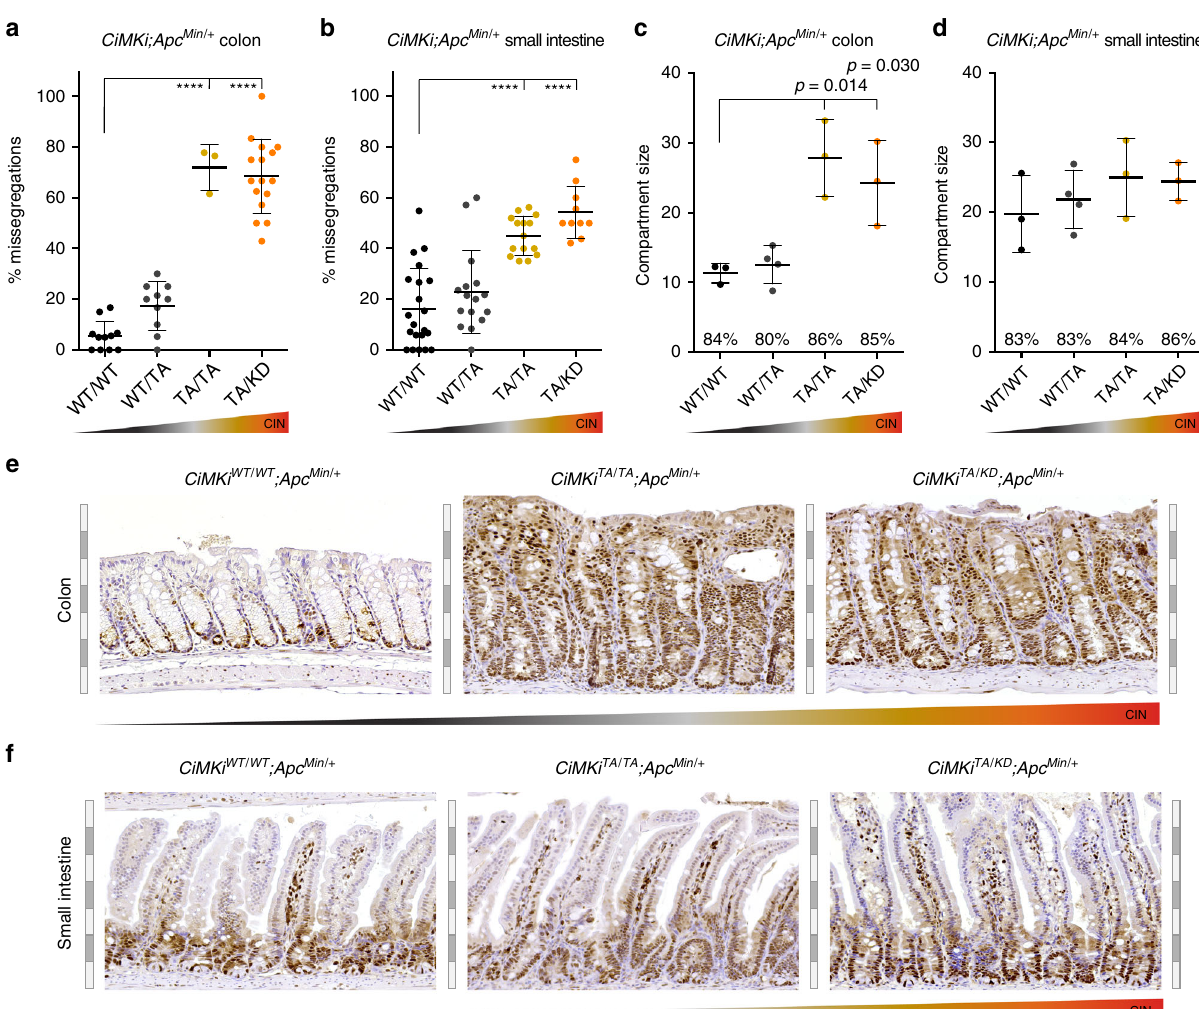
Fig. 4 Enhanced proliferation in colon but not in small intestine. a , b Quanti fi cation of chromosome segregation fi delity by time lapse imaging of colon organoids ( n = 11 (WT/WT), n = 10 (WT/TA), n = 3 (TA/TA), n = 16 (TA/KD)) ( a ) and small intestine organoids ( n = 21 (WT/WT), n = 16 (WT/TA), n = 15 (TA/TA), n = 10 (TA/KD)) ( b ), with at least 5 divisions per organoid, from various CiMKi;Apc Min/ + ;Villin-CreER T2 genotypes. Data represents mean ± SD, each dot is one organoid. c , d Proliferative compartment in colon ( c ) and small intestine ( d ) of 4-week old CiMKi;Apc Min/ + ;Villin-Cre mice as determined on ki67 stained tissue sections by scoring the number of cells between the fi rst positive cell at the bottom of the crypt and the last positive cell in the transit amplifying zone (for example images see Supplementary Fig. 2G, H). Dot plots show the average size of the compartment for each mouse (10 crypts (with normal appearance, selected from similar regions (~2/3 from proximal site) per mouse), and mean ± SD of 3 mice (WT/WT, TA/TA, TA/KD), or 4 mice (WT/TA) per genotype. Percentages indicate proliferative index (percentage of ki67 positive cells within compartment) for each genotype. e , f PCNA staining of tissue sections from colon ( e ) and small intestine ( f ) of 4-week old CiMKi;Apc Min/ + ;Villin-Cre mice, as a proxy for proliferative activity, showing increased size and PCNA positivity of colon crypts from CiMKi TA/TA ;Apc Min/ + ;Villin-Cre and CiMKi TA/KD ;Apc Min/ + ;Villin-Cre mice. Images are from one of three mice per genotype (see Supplementary Fig. 4A, B). Alternating gray and white scale bars 50 μ m. Crypts were selected from similar regions (~2/3 from proximal site). Statistics for panels a – d : one-tailed Welch ’ s t -test, comparing each group to CiMKi WT/WT ;Apc Min/ + ;Villin-Cre(ER T2 ) , exact p -values are indicated when p < 0.05, and p < 0.0001 is indicated by asterisks (****). Source data for panels a – d are provided as a Source Data fi